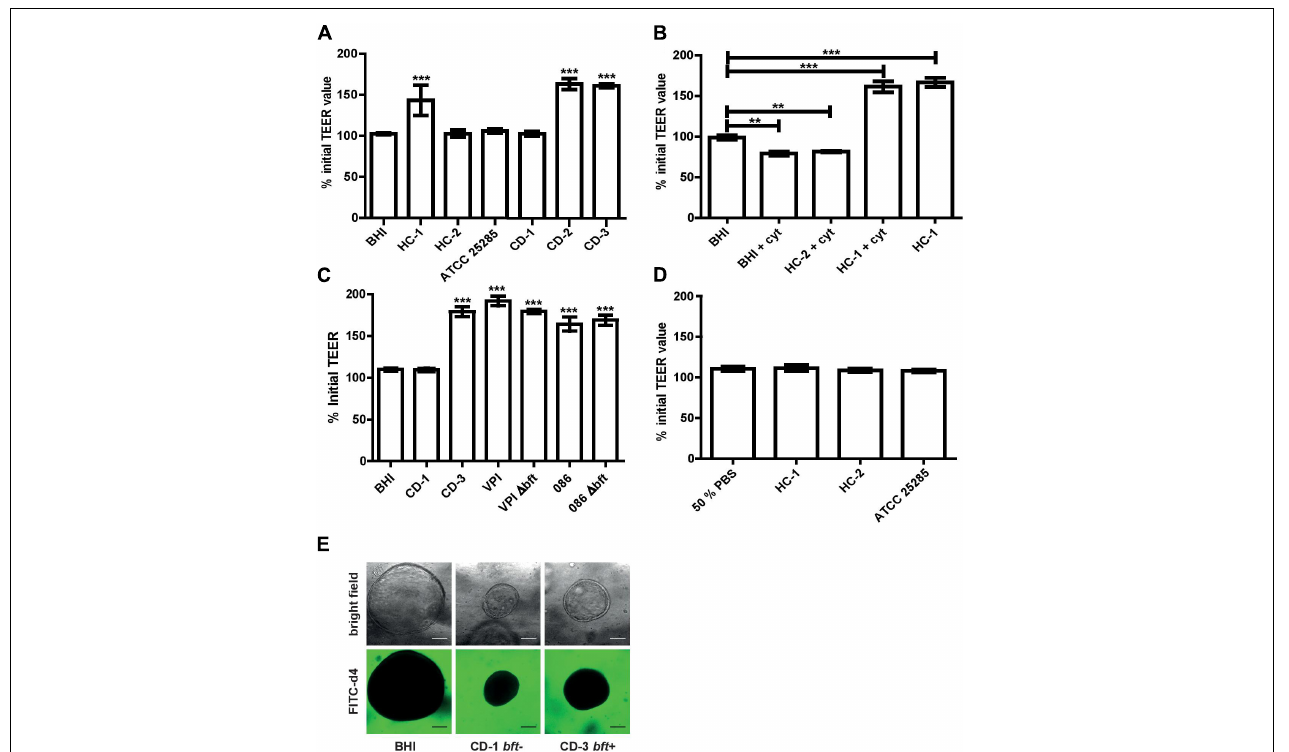
FIGURE 3 | Barrier function examination of Caco-2 monolayer and colonic organoids exposed to B. fragilis culture supernatant and MVs. (A) Luminally applied B. fragilis concentrated culture supernatant of HC-1, CD-2, and CD-3 led to increased TEER after 24 h. (B) Pre-incubation with 100 ng/ml TNF- α and IFN- γ could not impair the TEER enhancing effect of HC-1. (C) Luminally applied B. fragilis concentrated culture supernatant of 086, 086 (cid:49) bft-2 , VPI, and VPI (cid:49) bft-1 led to increased TEER after for 24 h. (D) Luminally applied MVs, isolated from different B. fragilis strains, did not lead to TEER alterations in Caco-2 cell monolayers after 24 h. (E) CD patient-derived colonic organoids treated basally with B. fragilis CD-1 and CD-3 concentrated supernatant and FITC d4 (green) remain a stable barrier after 24 h incubation. Means ± SD was based on triplicates of one representative experiment. cyt, cytokines; BHI, brain heart infusion broth. ** p < 0.01, *** p <